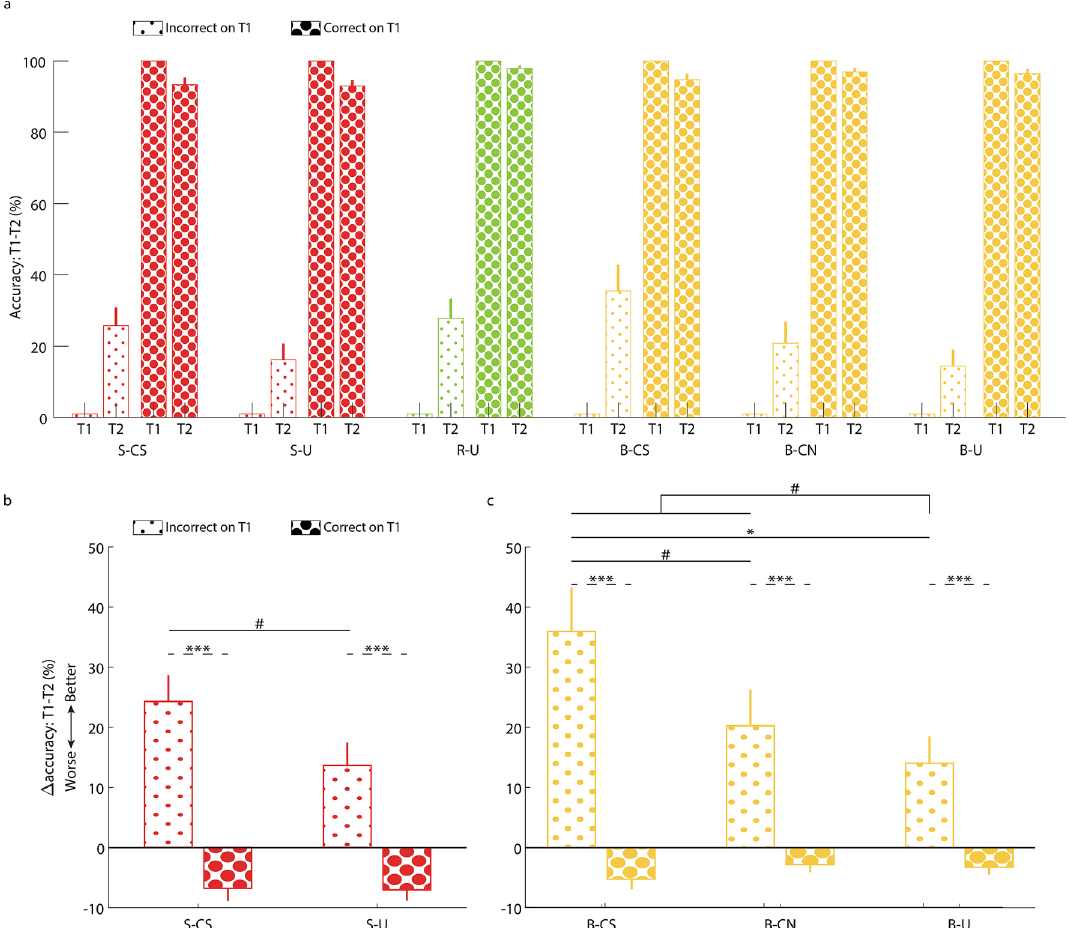
Figure 5. The benefit of reactivation for weakly encoded memories, as revealed by considering accuracy rates in T1. ( a ) Recall accuracy in T1 and T2 as a function of condition and whether recall occurred at T1 (large dots) or did not occur at T1 (small dots). Note that T1 results for all non-recalled conditions are at zero and the T1 results for all recalled conditions are at 100%, by definition. Error bars denote standard error of the mean between participants. ( b ) Changes in recall accuracy compared for the two suppression conditions, showing a trend toward memory improvement preferentially for the words that were not recalled in T1. There were also significant differences that were a byproduct of our segregation between items recalled in T1 and those that were not recalled. These differences are marked by dashed lines. ( c ) A parallel analysis conducted for the three baseline conditions showed a marginal difference between items that were not recalled at T1 in the B-CS condition and those of the B-CN condition; and a significance difference between items from the B-CS and B-U conditions that were not recalled in T1. Values in panels ( b ) and ( c ) reflect coefficient estimates produced by the linear model; error bars in panels ( b ) and ( c ) denote standard error of the mean for coefficients. # p < 0.1, * p < 0.05; *** p < 0.001. S-CS suppression–cued suppression, S-U suppression–uncued, R-U response–uncued, B-CS baseline–cued suppression, B-NS baseline–cued novel, B-U